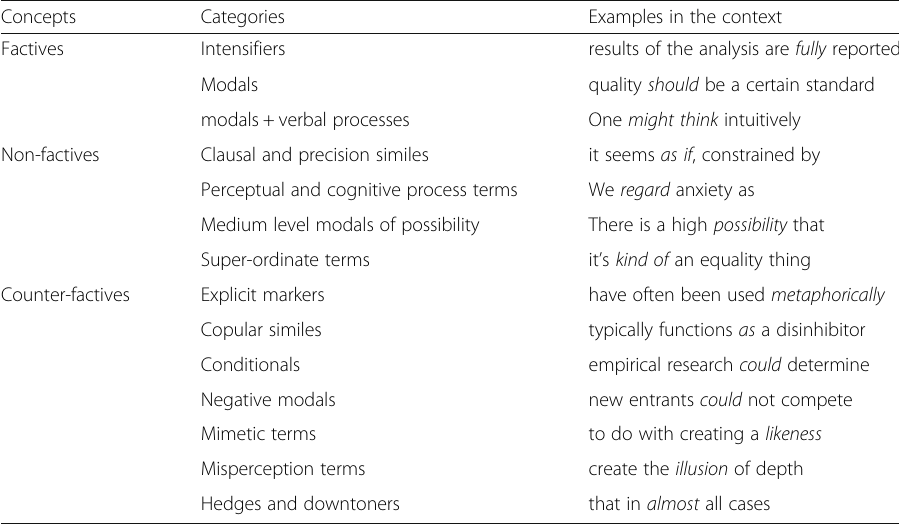
Table 6 Goatly ’ s (1997) framework of metaphorical markers